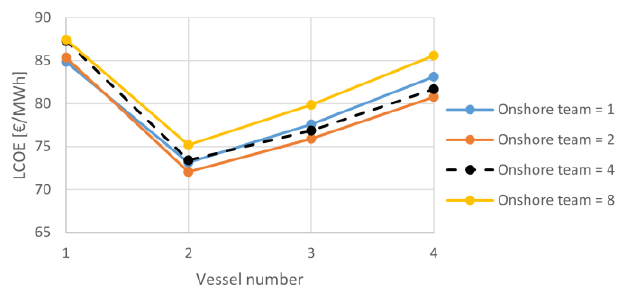
Fig. 28. LCOE versus vessel number for various numbers of onshore teams, in the case of c/d time=2.5 hr and assembly team=3.